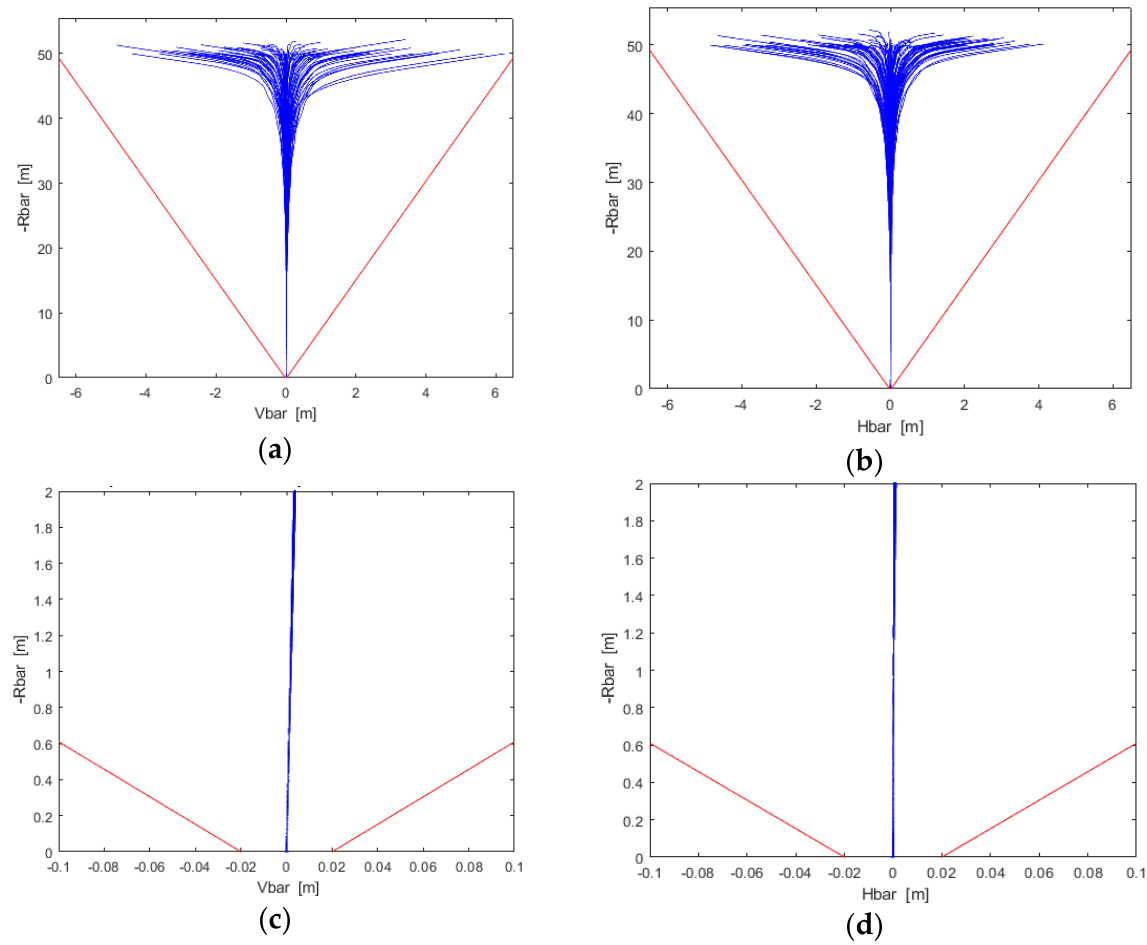
Figure 9. The 2D trajectory in ( a ) H-bar-R-bar plane and ( b ) V-bar-R-bar plane, and the detail of the last 2 m in ( c ) H-bar-R-bar plane and ( d ) V-bar-R-bar plane.